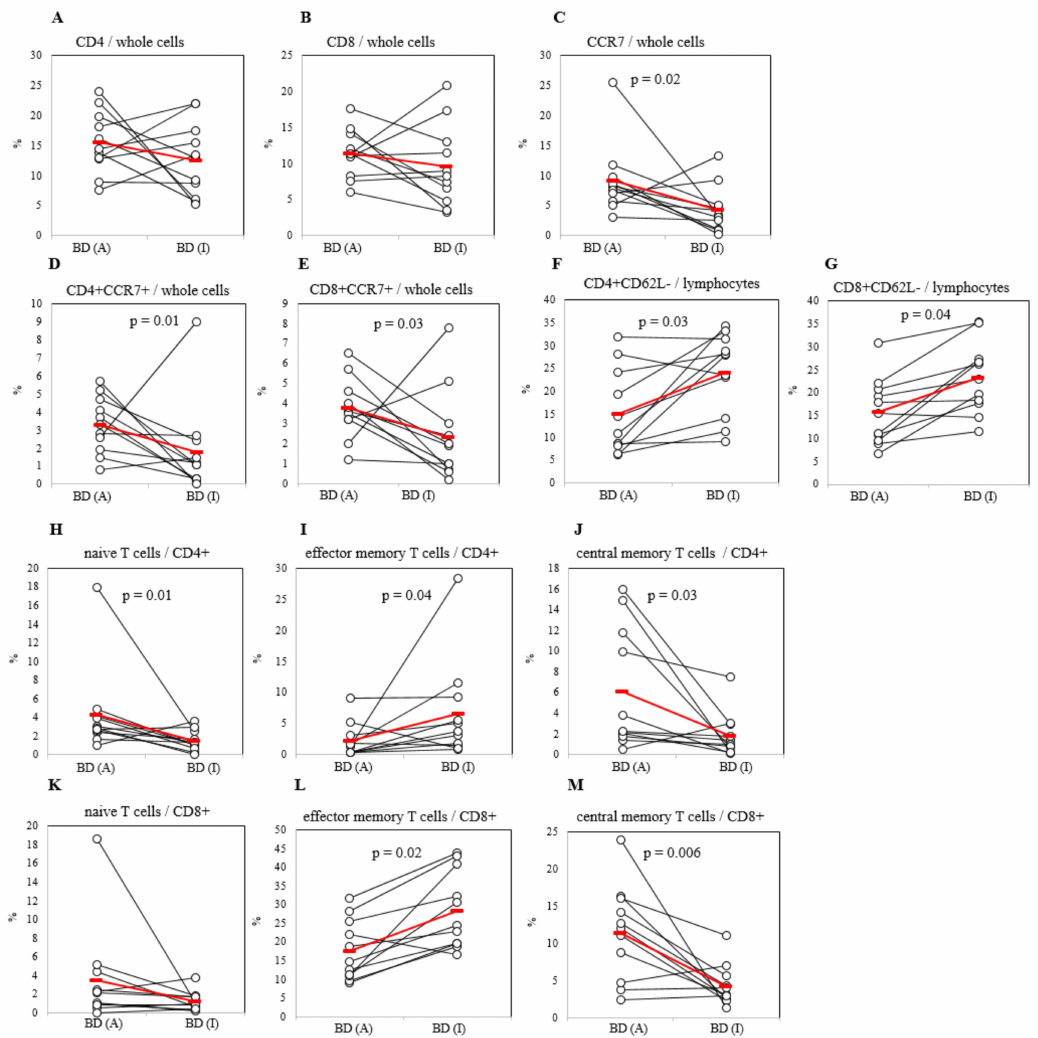
Figure 3. Frequencies of CD4 + and CD8 + cells with CCR7 + in whole cells ( A–E ), and with CD62L- cells in lymphocytes ( F,G ) of active Behçet’s disease (BDA) and inactive BD (BDI) patients. Frequencies of naïve T, e ff ector memory T, central memory T cell subsets in CD4 + T cell subset ( H–J ), and in CD8 + T cell subset ( K–M ) of active Behçet’s disease (BDA) and inactive BD (BDI) patients. Isolated peripheral blood leukocyte (PBL) cells were subjected to FACS analysis by surface staining. Results were obtained from active stage and inactive stage of 11 BD patients. The P -value was determined by Wilcoxon rank-sum